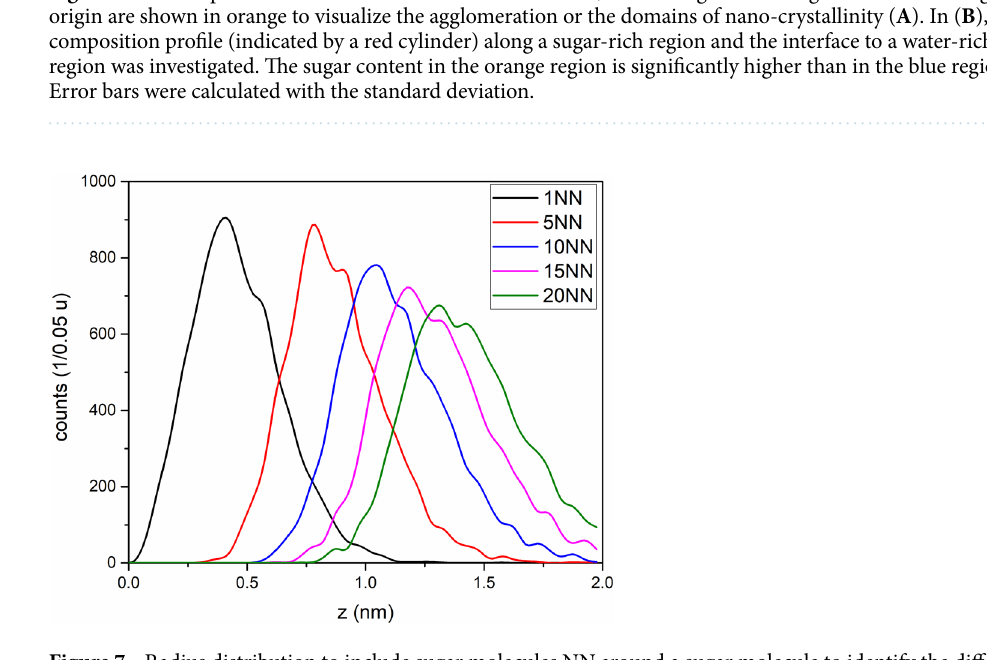
Figure 7. Radius distribution to include sugar molecules NN around a sugar molecule to identify the different distances within both